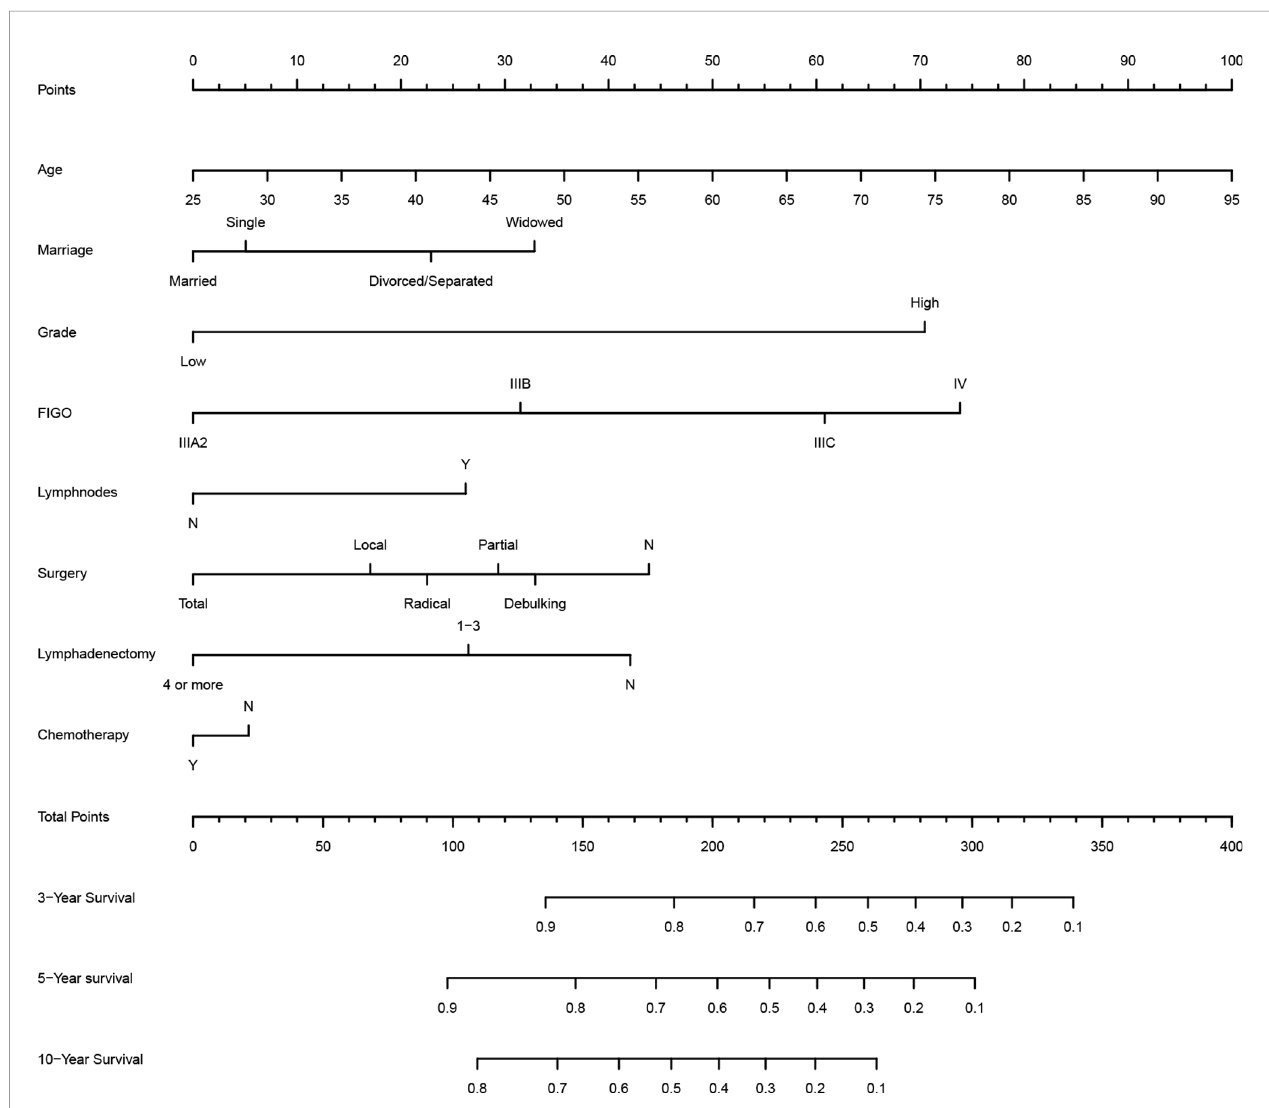
FIGURE 1 | Survival nomogram to predict the 3-, 5-, and 10-year OS of PPSC